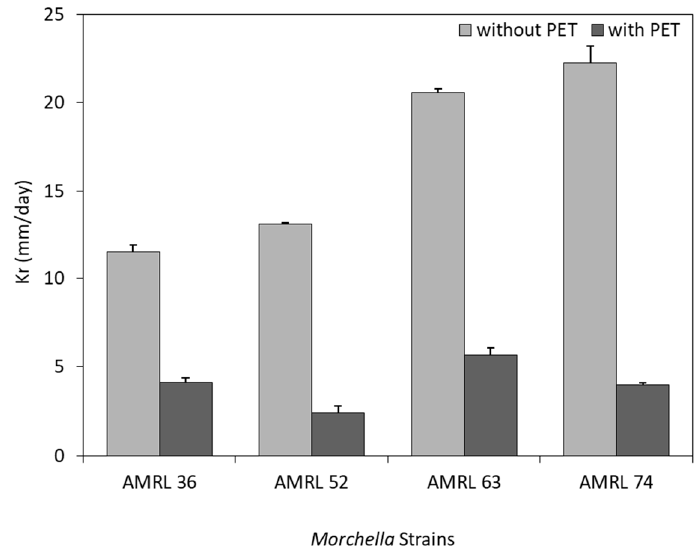
Figure 1. Growth rate of yellow (AMRL 36, 52) and black (AMRL 63, 74) morel strains during solid-state fermentations on potato dextrose agar (PDA), with and without polyethylene terephthalate (PET) membrane.